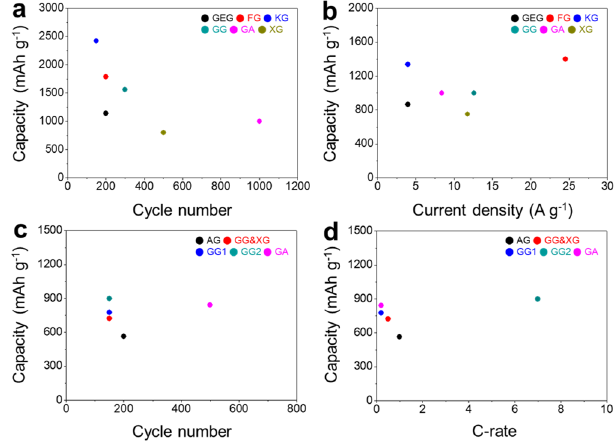
Figure 7. Comparison of various natural gum-based binders for Si electrode in terms of ( a ) cycle retention and ( b ) rate capabilities. Comparison of various natural gum-based binders for S electrode in terms of ( c ) cycle retention and ( d ) corresponding capacity vs. c-rate.